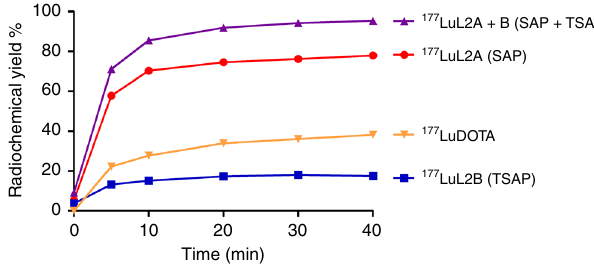
Fig. 8 Radiolabeling yields of 177 Lu complexes. A graph of the radiolabeling yields of L2 and DOTA with 177 Lu(III) against time at 95 °C in pH 5.0 buffer, showing that L2 is a better chelator for 177 Lu(III)